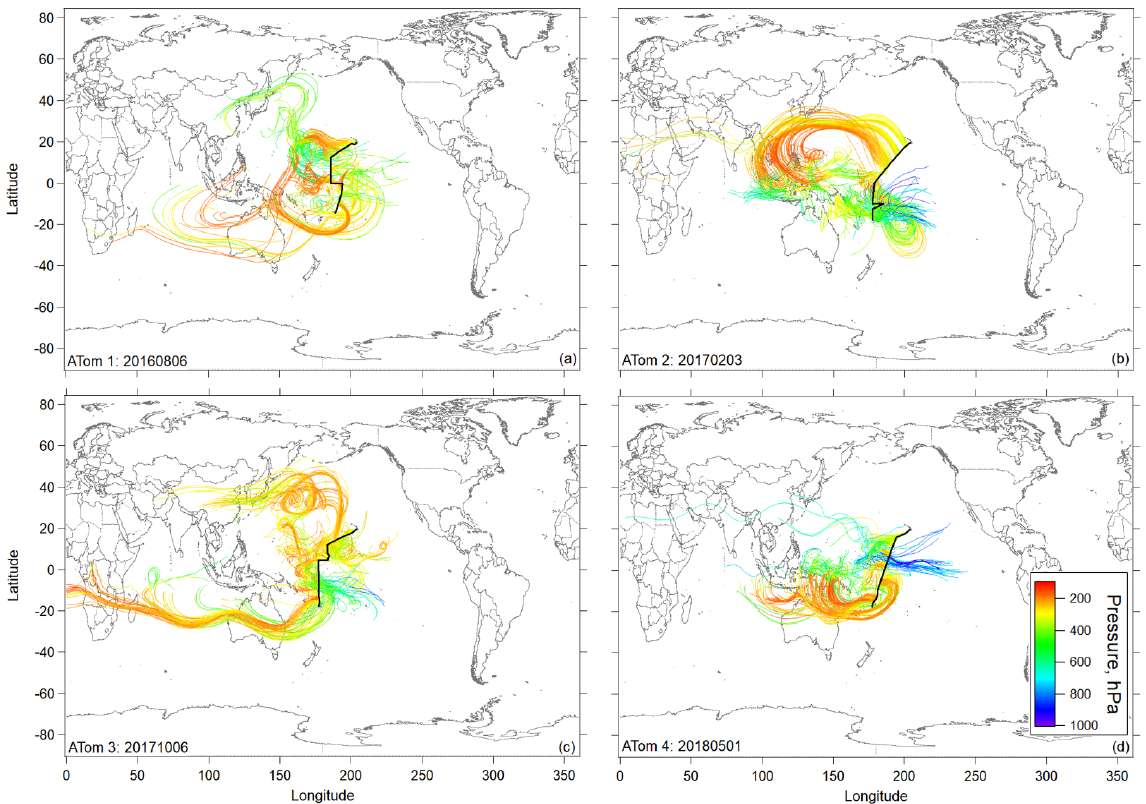
Figure 3. Flight track and selected 10d backward trajectories initiated for times in flight at pressures < 400hPa ( < ∼ 260K) sampled along the DC-8 flight track during ATom missions 1, 2 (a, b) , 3, and 4 (c, d) during the most tropical flight in each deployment (Hawaii–Samoa on ATom 1 and Hawaii–Fiji on ATom missions 2–4). Trajectories are colored according to the pressure along their